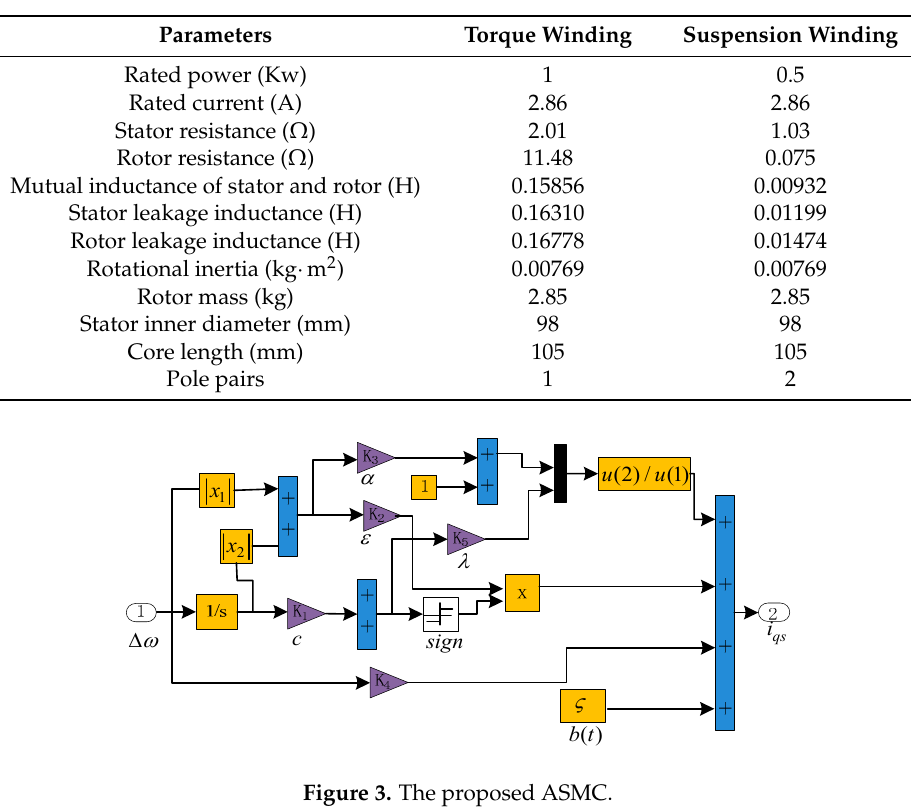
Table 1. Parameters of the Bearingless Induction Motor (BIM).